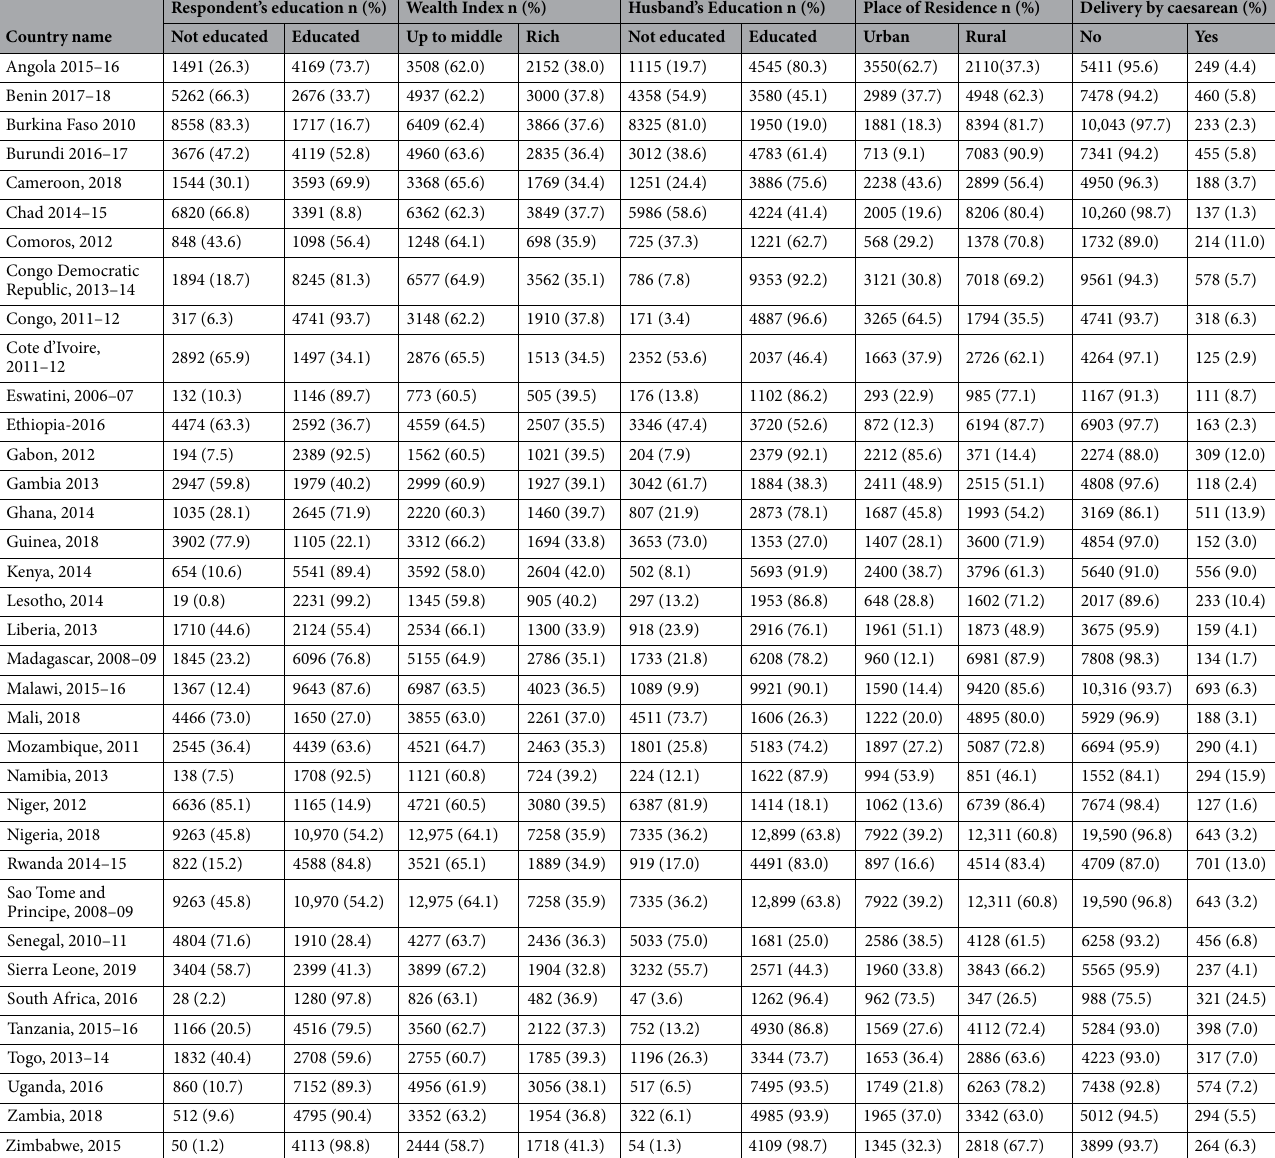
Table 1. Baseline characteristics table for selected variables for different